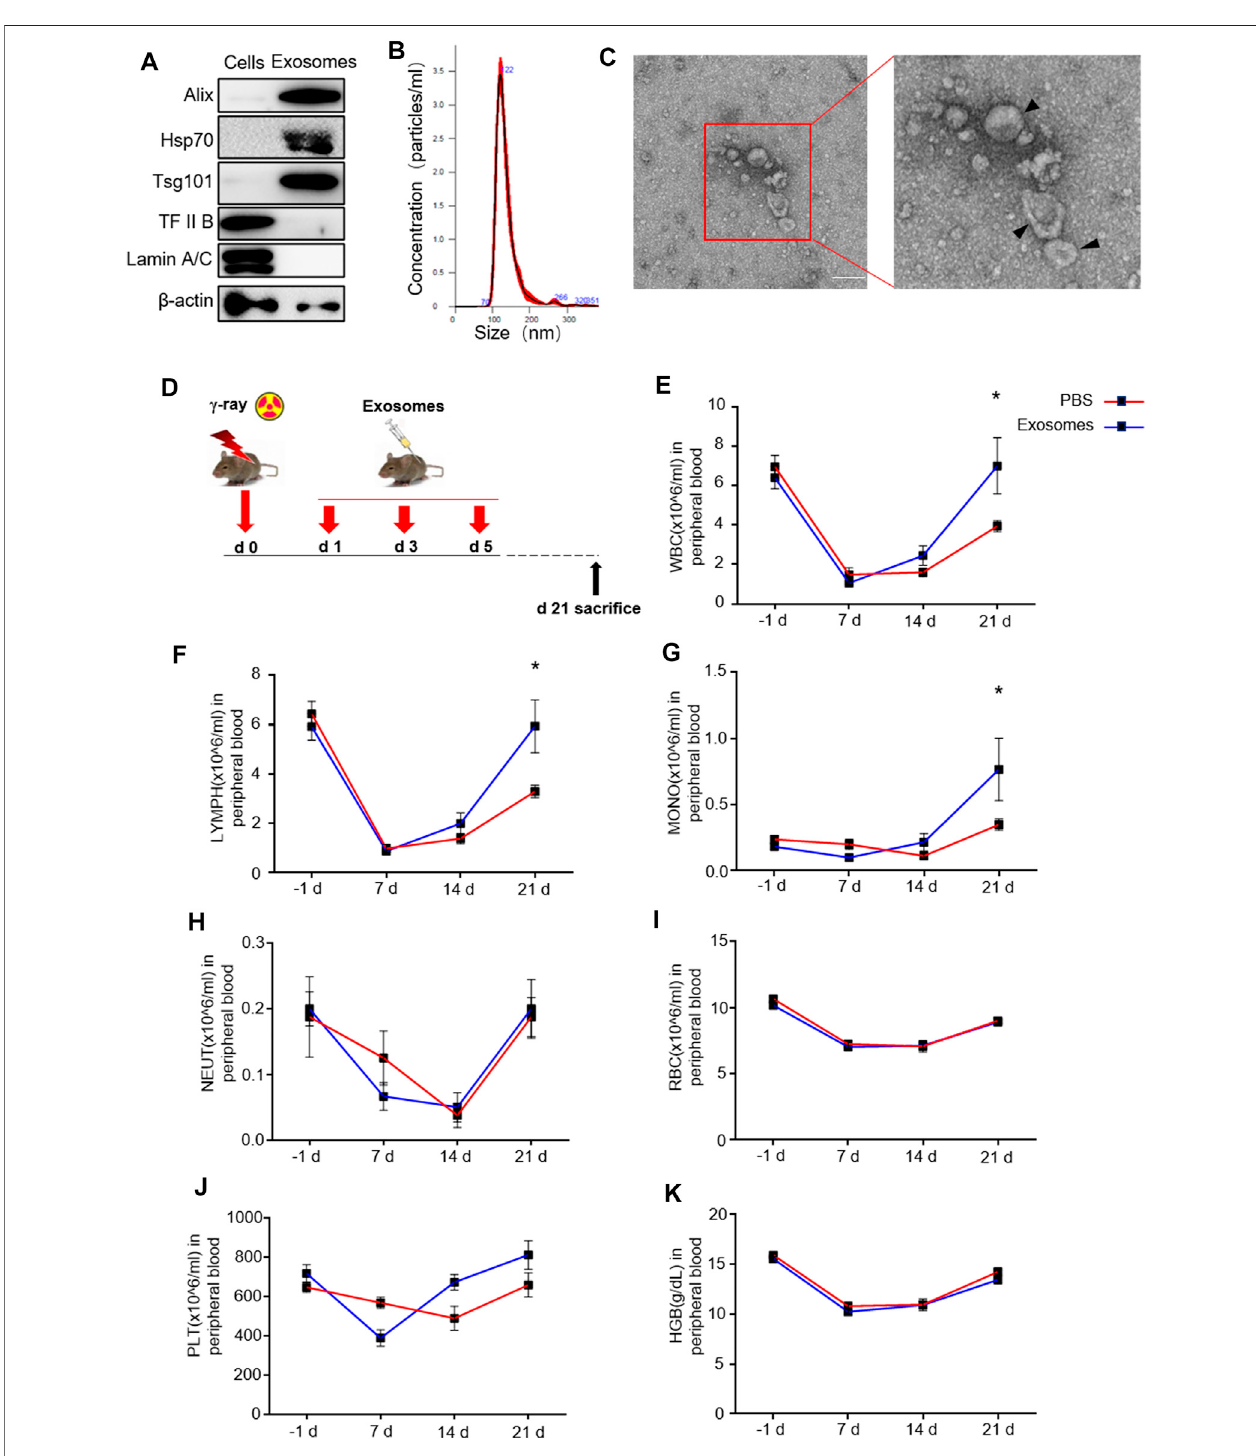
FIGURE 1 | Osteoblast derived exosomes promote white blood cell, lymphocyte and monocyte recovery after irradiation. (A) Detection of protein levels of Alix, HSP70, TSG101, TFIIB and Lamin A/C in OB-exosomes and parental cell lysates by western blot. (B) Nanoparticle tracking the size distribution of OB-exosomes (representative of fi ve independent measurements). (C) Representative transmission electron microscope (TEM) images of OB-exosomes. Scale bar, 200 nm. (D) The mice were injected with PBS or OB-exosomes immediately after 5 Gy TBI at 1st, 3rd, 5th day after irradiation. (E) white blood cell counts, (F) lymphocytes counts, (G) monocyte counts, (H) neutrophils counts, (I) red blood cell counts, (J) platelet counts and (K) hemoglobin level weremeasured by ahematology analyzer.Statistical analysis of peripheral blood cell number in irradiated mice injected with PBS (n = 8) and osteoblast-exosomes (* p < 0.05, mean ± sem, n = 6).